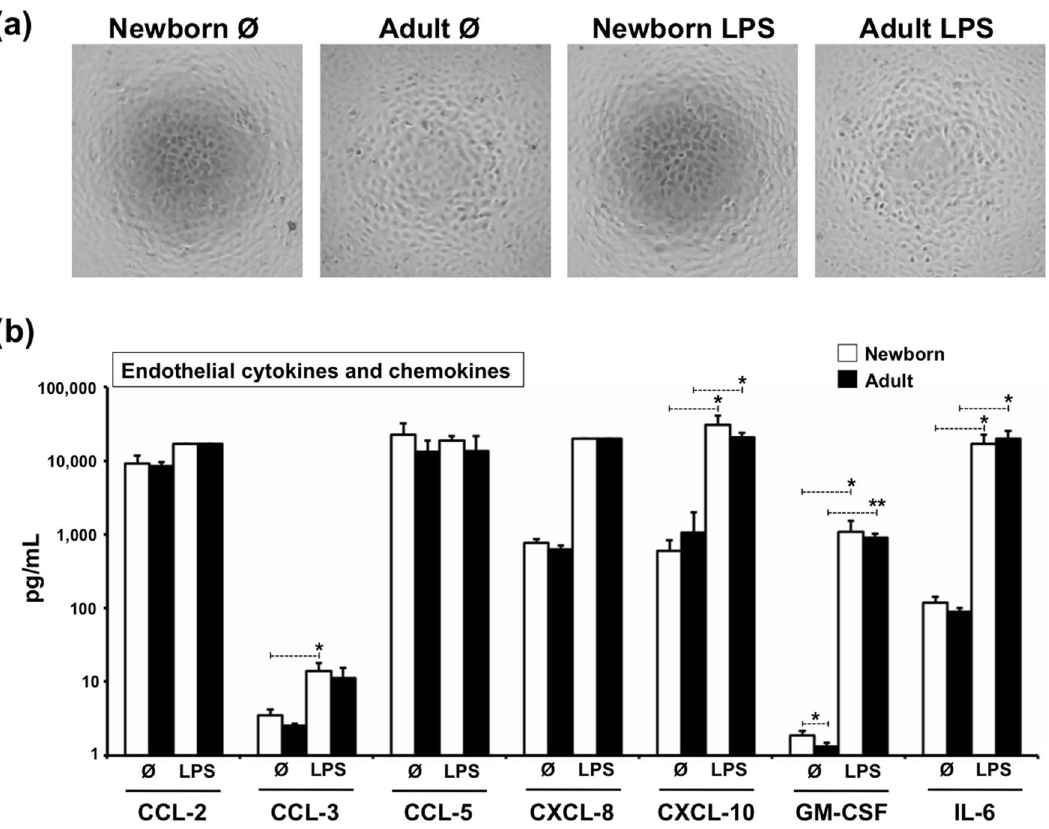
Figure 4. Cytokines and chemokines released by endothelium in the presence of autologous plasmas. Cytokines and chemokines were measured on study participant’s autologous plasmas (N = 3/age-group) after being over either quiescent or stimulated TCs devoid of monocytes for 12 h at 37 °C/5%CO 2 . 1 mg/mL LPS was used to stimulate TCs for 12 h, as described in methods. Unstimulated controls (Ø) received 1% DMSO. ( a ) Microscopic analysis of endothelium after stimulation (representative images, 4X). ( b ) Analytes measured were IL-1β, IL-6, CXCL8 (IL-8), IL-10, IL-12p40, IL-12p70, TNF-α, IFN-α2, IFN-γ, CXCL-10 (IP-10), CCL-2 (MCP-1), GM-CSF, CCL-3 (MIP-1α) and CCL-5 (RANTES). Chemokines CCL-2 and CXCL-8 in stimulated group reached their maximum detection limit. Cytokines IL-1β, IL-10, IL-12p40, IL-12p70, TNF-α, IFN-α2 and IFN-γ were not detected in both age groups. UnPaired t-Test, two-tailed *P ≤ 0.05; **P ≤